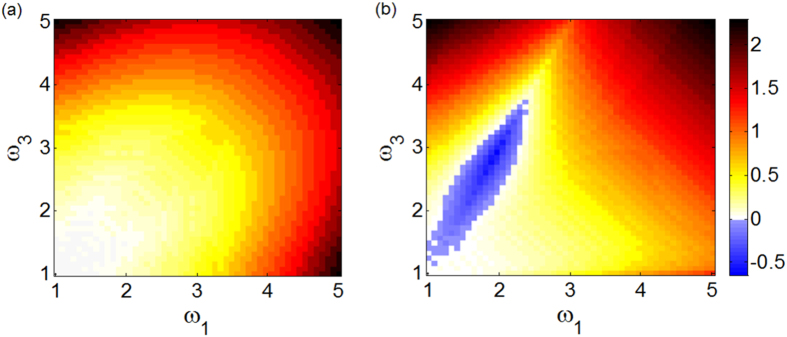
Behavior of  (color coded) as a function of ω1 and ω3 for ω2 = 1.01 in the closed (a) and open (b) triangle. For the closed triangle  is always positive, indicating an enhancement of synchronization occurring in this motif for SL oscillators, independently from the frequency distribution. For the open triangle, an enhancement is found independently from the specific values of the frequencies, only provided that ω1 > ω2, ω3 (or ω1 < ω2, ω3, data not shown).